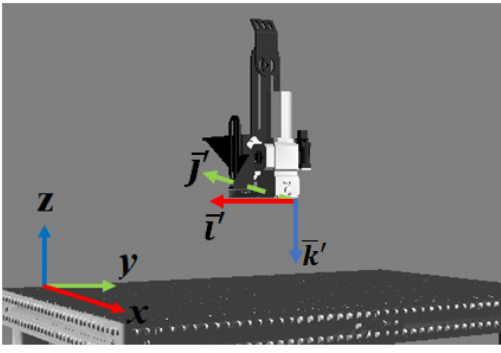
(cid:48) (cid:48) (cid:48) } relative to the base of the LRC-W , j , k